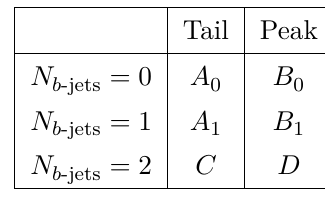
Table 4 . Division into orthogonal regions according to the N the two top-quark masses as defined in table 3.